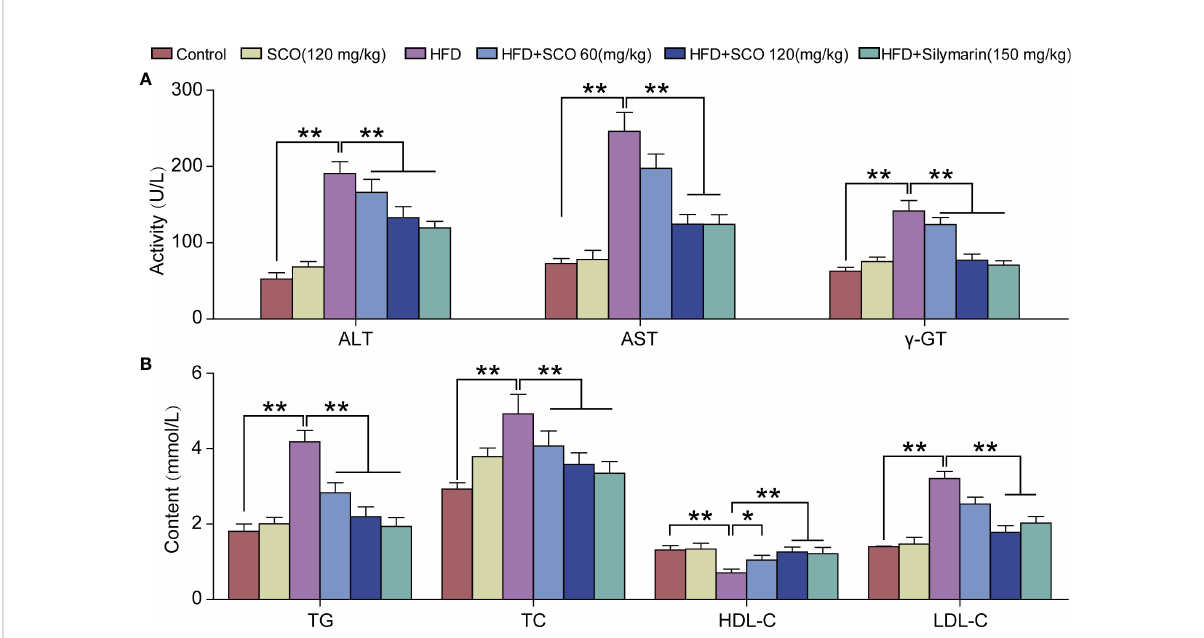
FIGURE 3 The results of detection of biochemical indicators. (A) Detection of serum liver function indicators of ALT, AST and g -GT. (B) Detection of hepatic lipid indicators of TG, TC, HDL-C and LDL-C. All data are presented as the mean ± SD (n = 10). The HFD group was compared to the Control group; the HFD + SCO (60, 120 mg/kg) groups and HFD + Silymarin group were compared to the HFD group, * P < 0.05, ** P <